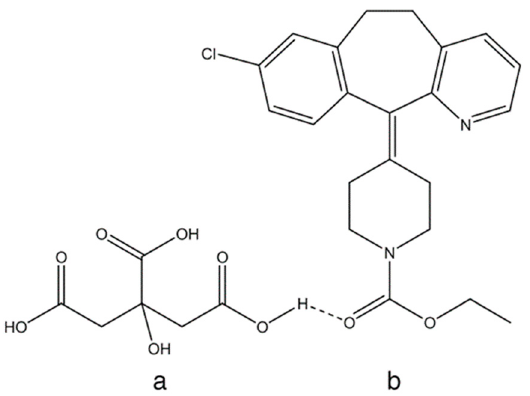
Figure 1. The co-amorphous system (a—citric acid, b—loratadine bonded with hydrogen bonds as a dotted line).